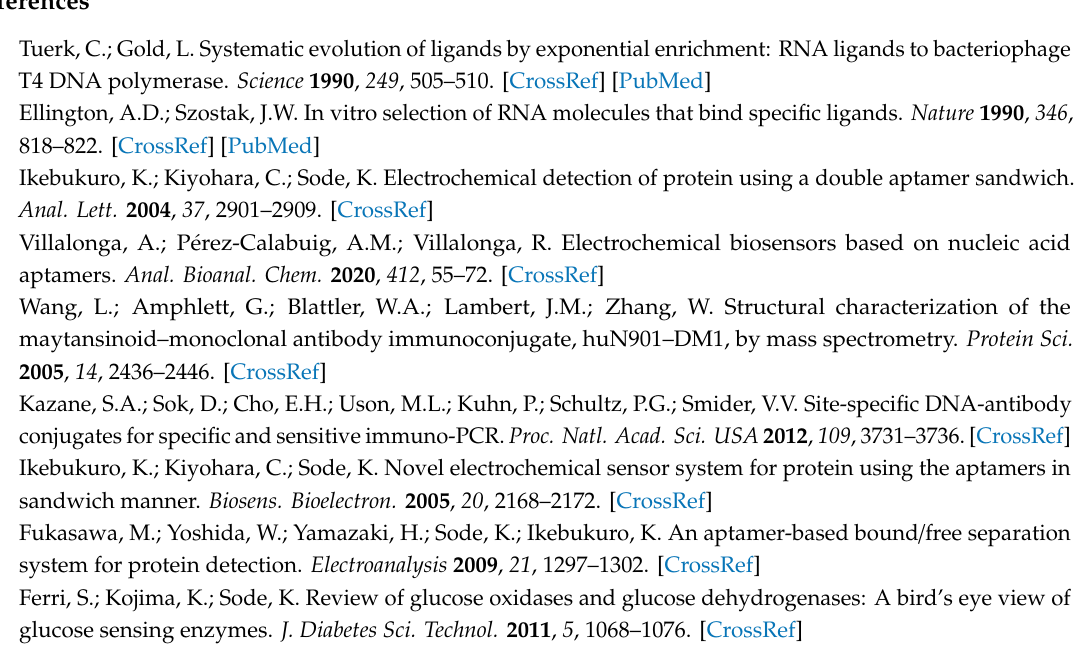
Supplemental Table S1: Sequences of oligonucleotides, Supplemental Table S2: Comparison of electrochemical VEGF aptamer sensors, Preparation of GDH-fused ZF, Figure S1: Kinetic parameters of purified AfGDH wild type and ZF-GDH, Figure S2: Predicted secondary structure of VEGF-binding aptamers after fusing ZF binding site, Figure S3: Binding specificity of ZF-GDH, Figure S4: VEGF concentration dependency on the microtiter plate, Figure S5: E ff ect of SAM modification on non-specific absorption of